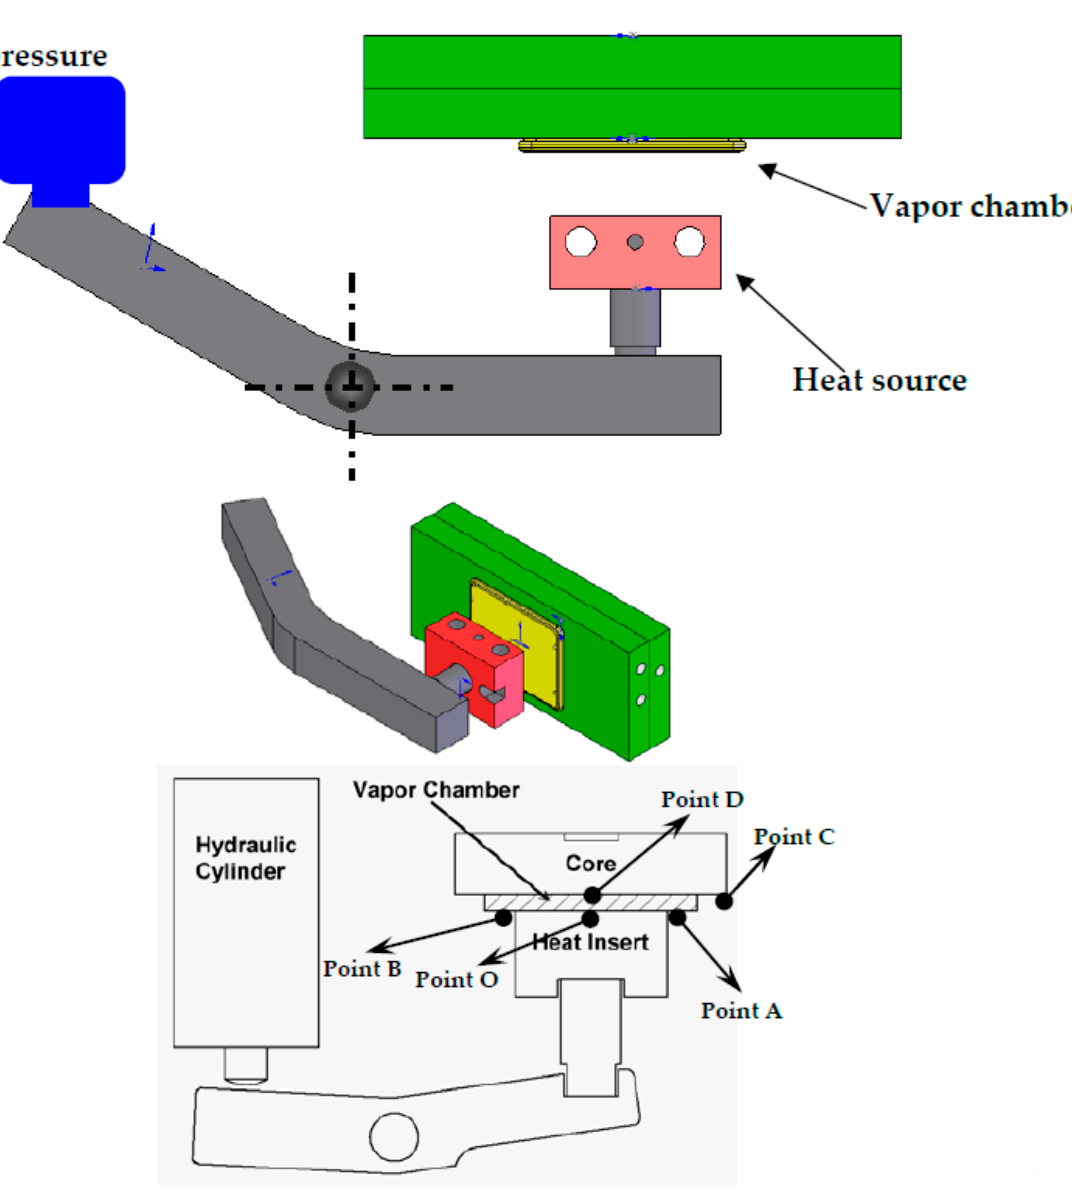
Figure 3. Mechanisms of heating and cooling cycle system with Vapor chamber (VCRHCS).